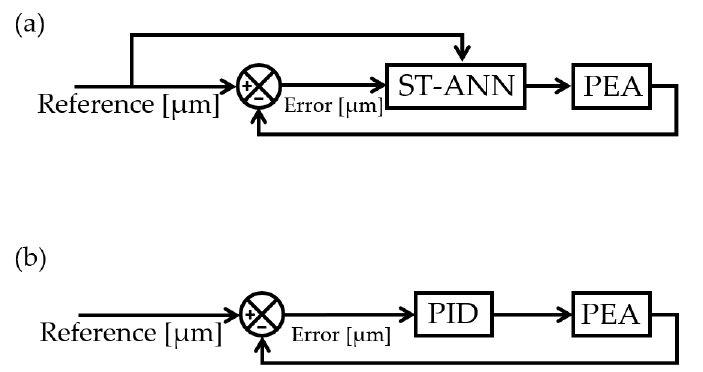
Figure 4. Control architectures used during the experiments. ( a ) ST -artificial neural networks (ANN); ( b ) feedback with proportional-integral-derivative